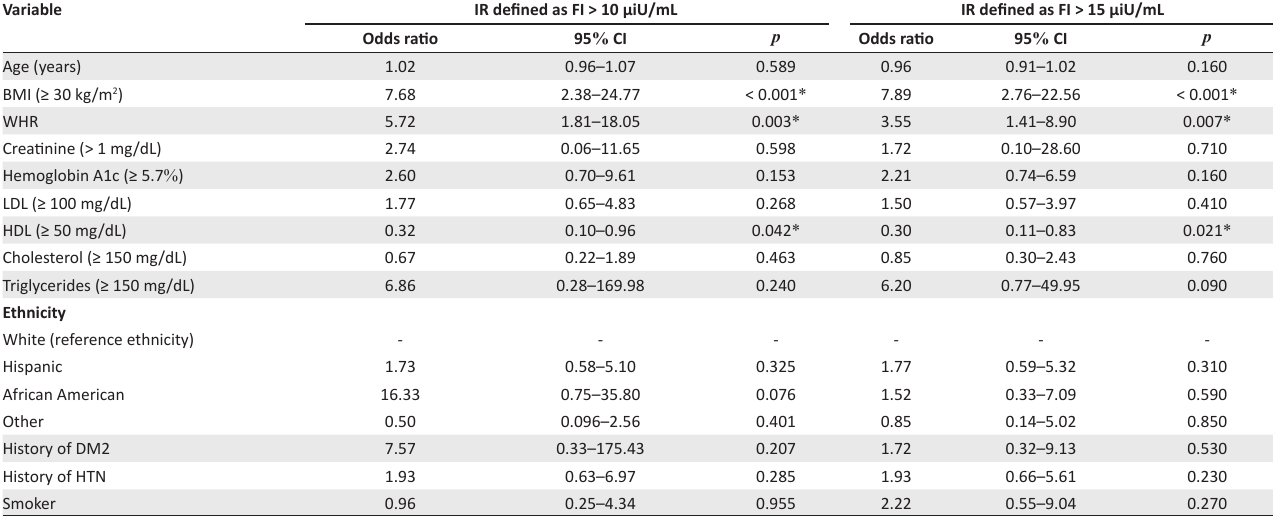
TABLE 4: Univariate analysis of risk factors for IR in women with AUB.